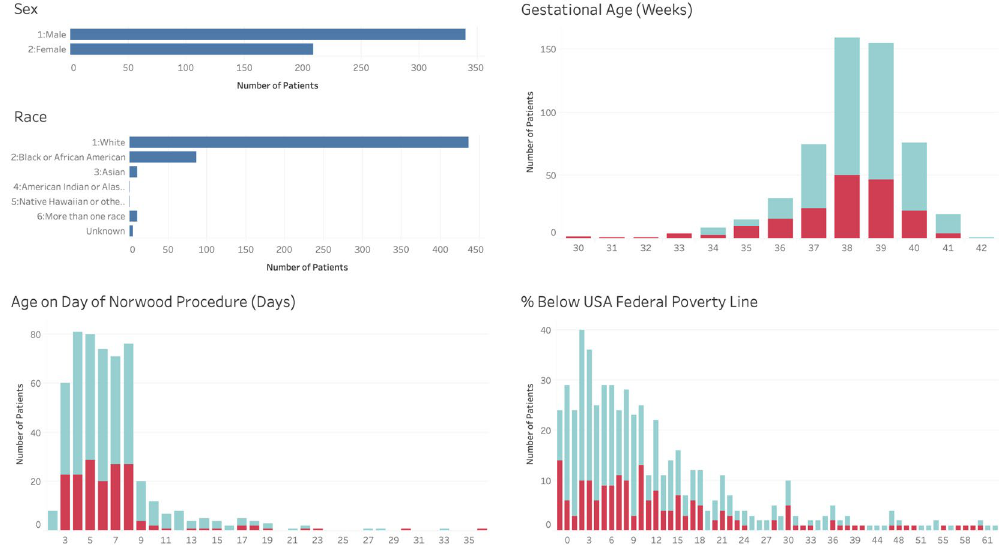
Figure 1. Demographics of patients in the PHN SVR dataset. The patient’s sex, race and age on the day of their Norwood surgical procedure is shown. Gestational age is the gestational age at birth reported in weeks, indicating presence and degree of prematurity with full term ≥ 37 weeks. % below federal poverty level is an indication of socioeconomic status. The turquoise color represents patients who survived to one year, red represents those who